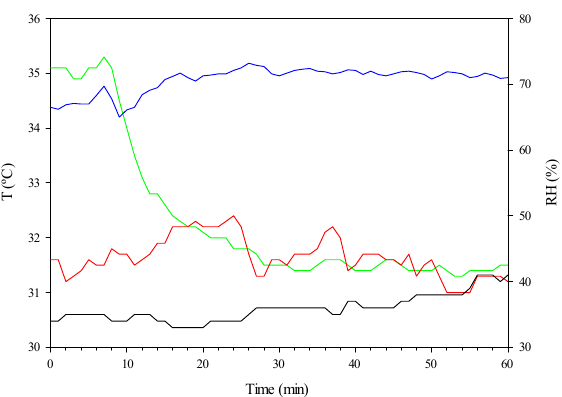
Figure 4. Temporary evolution of the temperature (T, °C, on the main axis; in the greenhouse, green, and outdoors, red) and relative humidity (RH, %, on the secondary axis; in the greenhouse, blue, and outside, black) during test 1 using the fan-pad system.